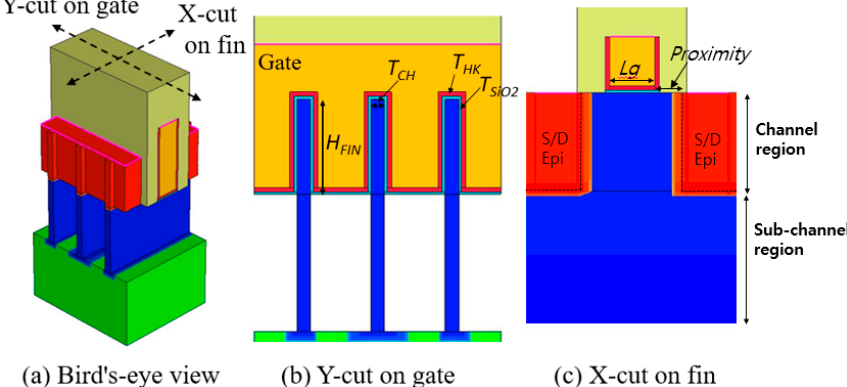
Figure 1. ( a ) Bird’s-eye and ( b , c ) cross-sectional views of FinFET. The major geometric device parameters are noted in the figures. Note that the fin shape is rectangular (not tapered). In addition, three fins are used in the channel region, and merged in epitaxially grown source/drain regions.